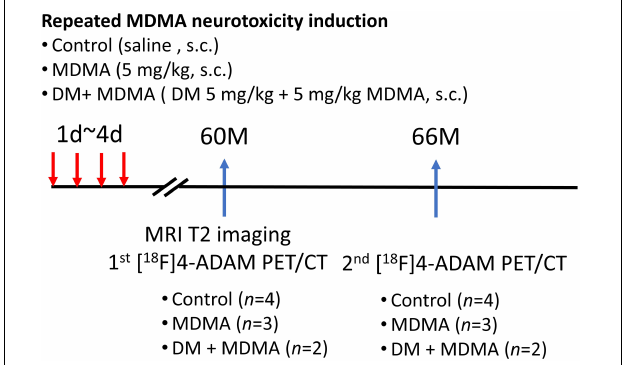
FIGURE 1 | Flowchart of the study design. A total of nine monkeys were randomized into three groups: control, MDMA, and DM + MDMA. The drugs were administered between day 1 and day 4 (twice a day for four consecutive days). MRI imaging was performed at 60 months and PET/CT imaging was performed at 60 and 66 months.